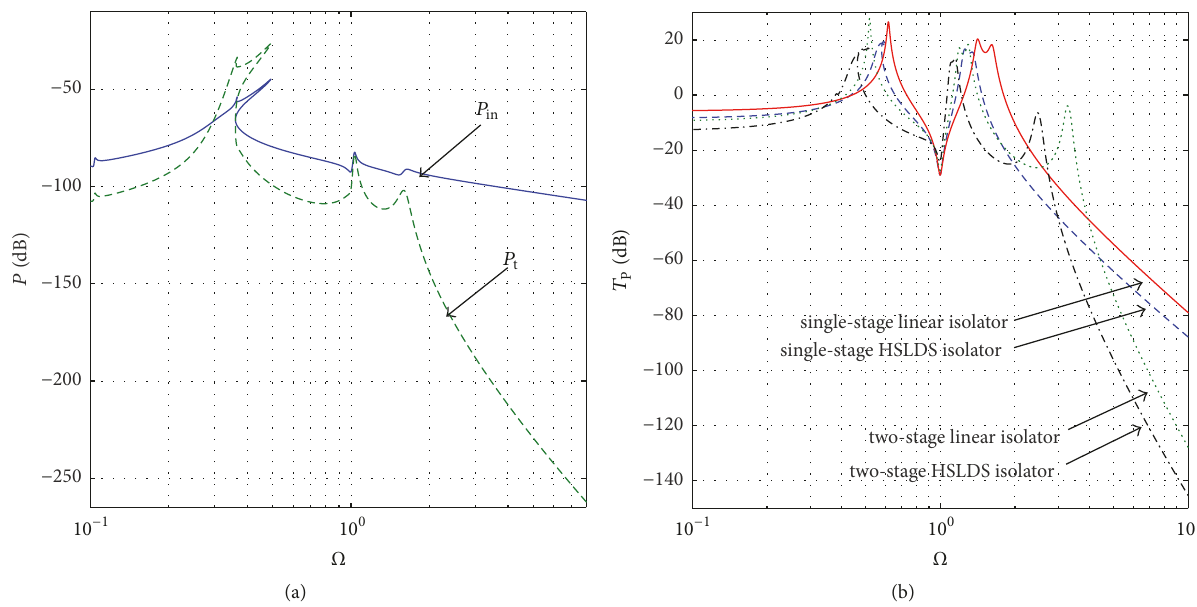
̂𝑘 = 1 , ̂𝑘 = ̂𝑘 = 0.9 , ̂𝑙 = 0.7 , s h 1 h 2